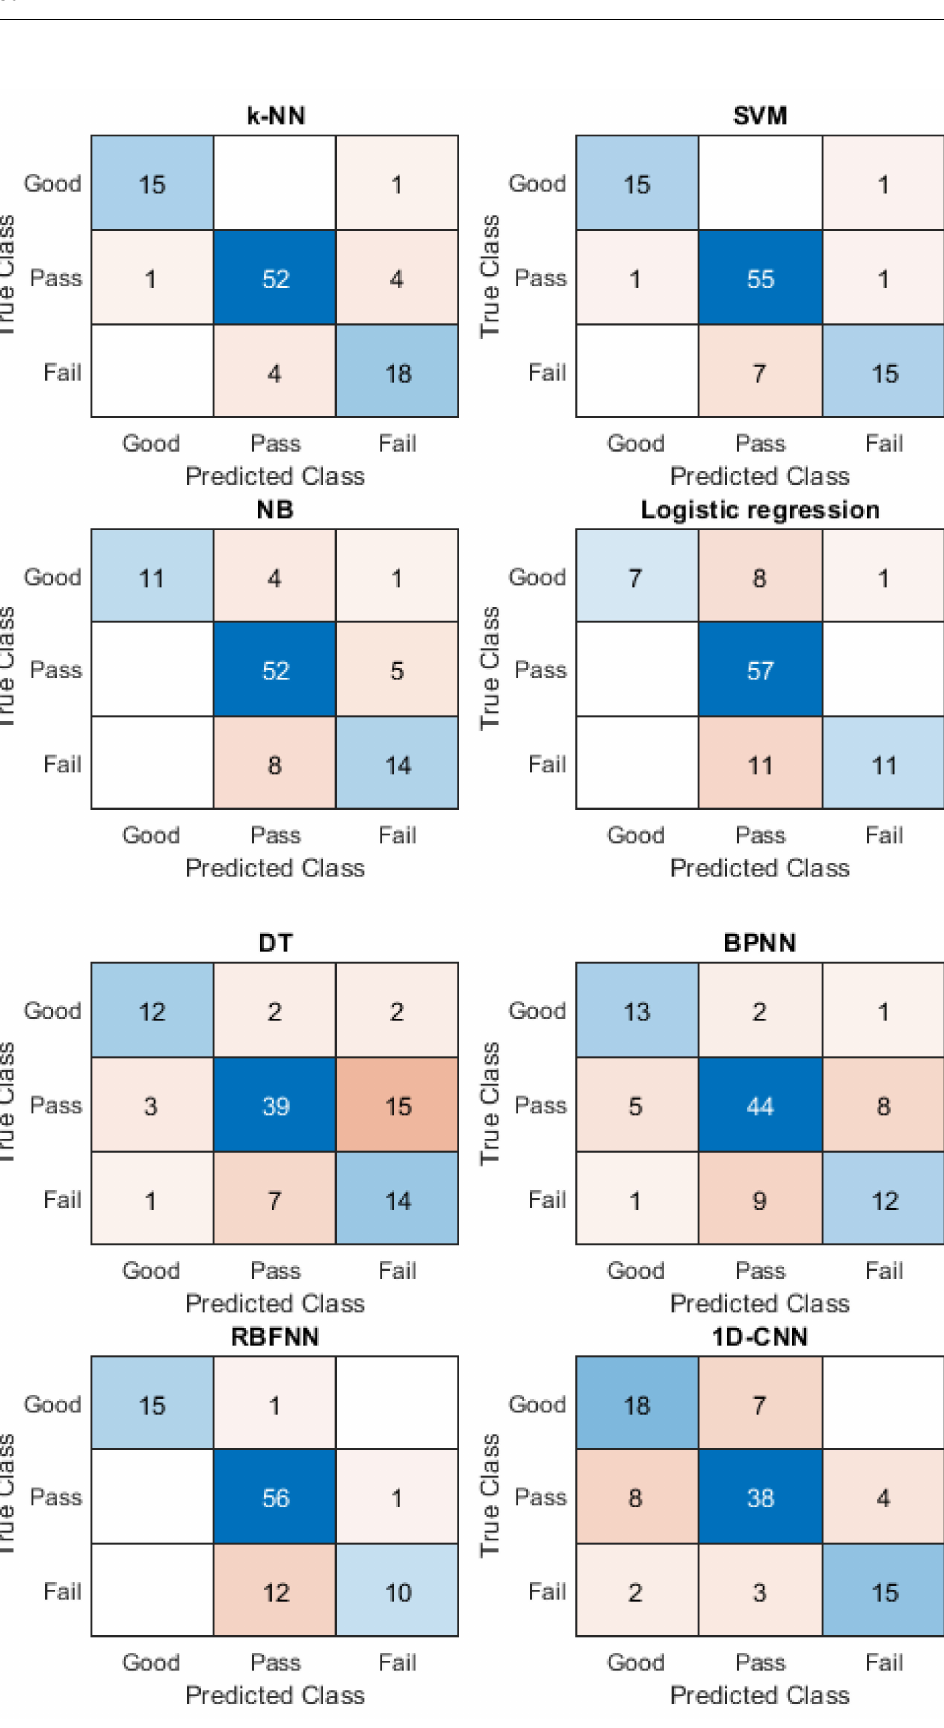
Figure 8. The confusion matrices of different classifiers for Motion-1, using scores from Teacher